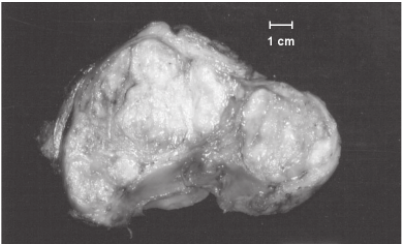
Figure 2a – Macroscopic features. A grossly circumscribed and lobulated yellow-white mass, with a glistening surface due to myxoid ground substance